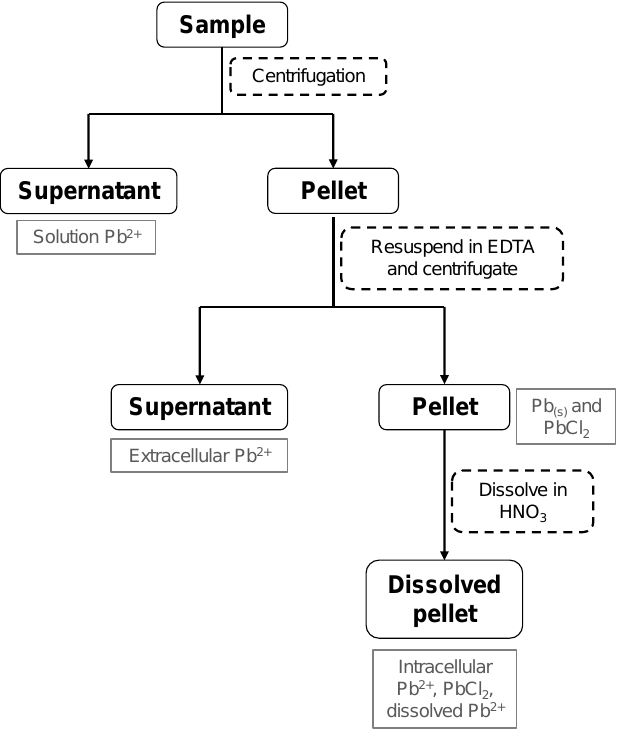
Figure 10. A description of the process to determine extracellular and intracellular Pb(II) concentra- tion as well as the other possible lead species present in the